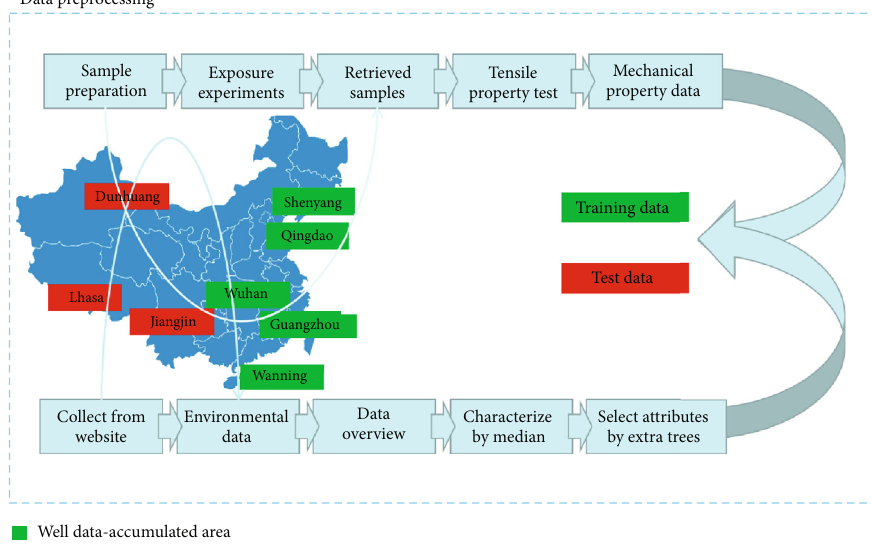
Figure 1: Schematic overview of the preprocessing